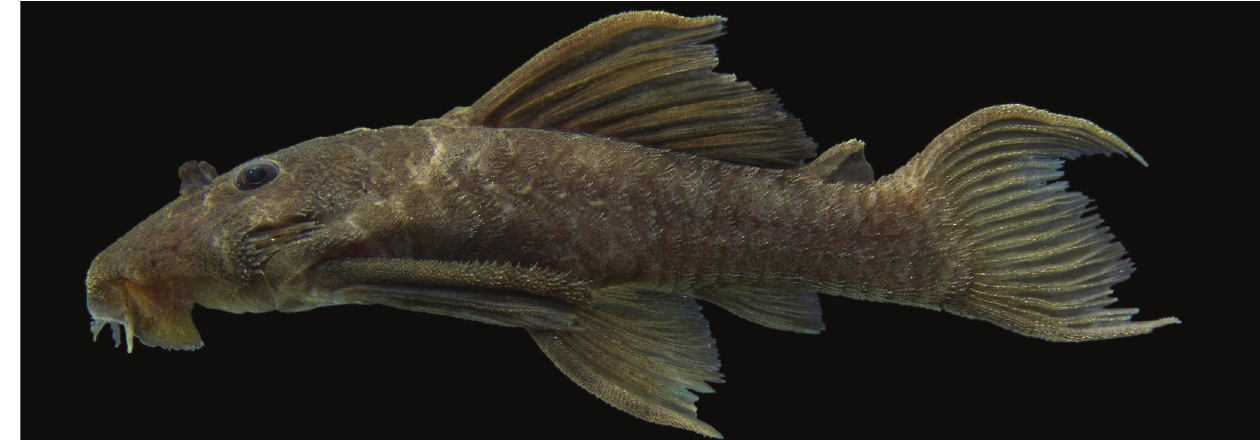
Fig. 10. Color in live of Spectracanthicus immaculatus , paratype, MZUSP 92617, 81.2 mm SL. Image by L. Sousa.